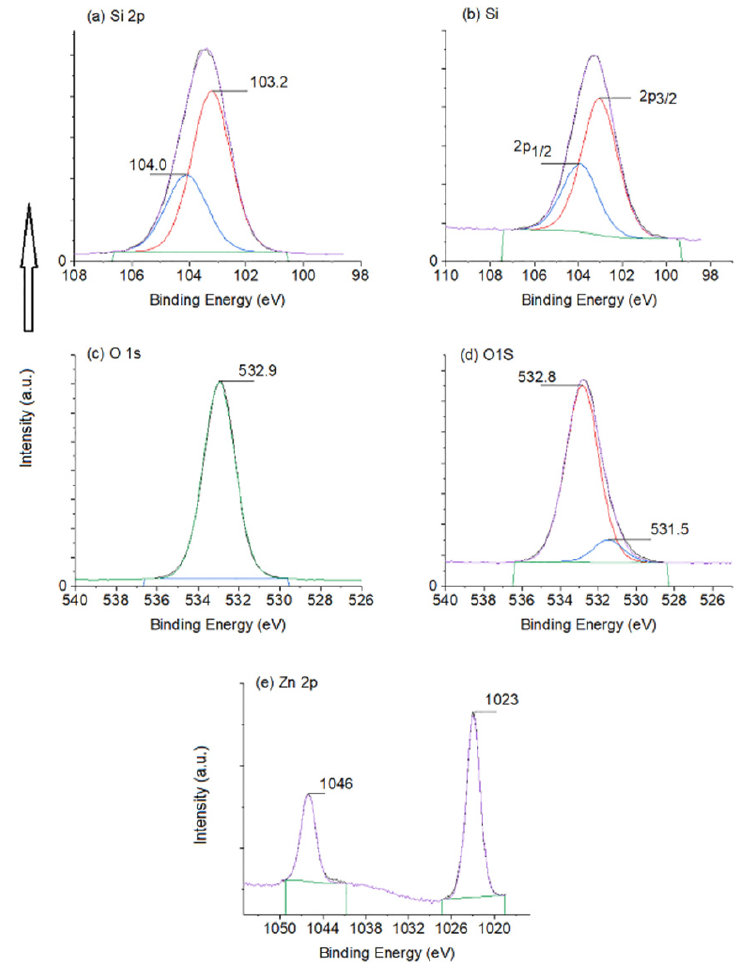
Figure 2. ( a – c ) Bright-field TEM images from different sections of ZnO-SBA-11, ( d ) is the dark-field TEM image of ( c ), ( e ) is the corresponding energy dispersive X-ray spectroscopy (EDX) of ( c , d ), and ( f ) is an enlargement of ( e ).